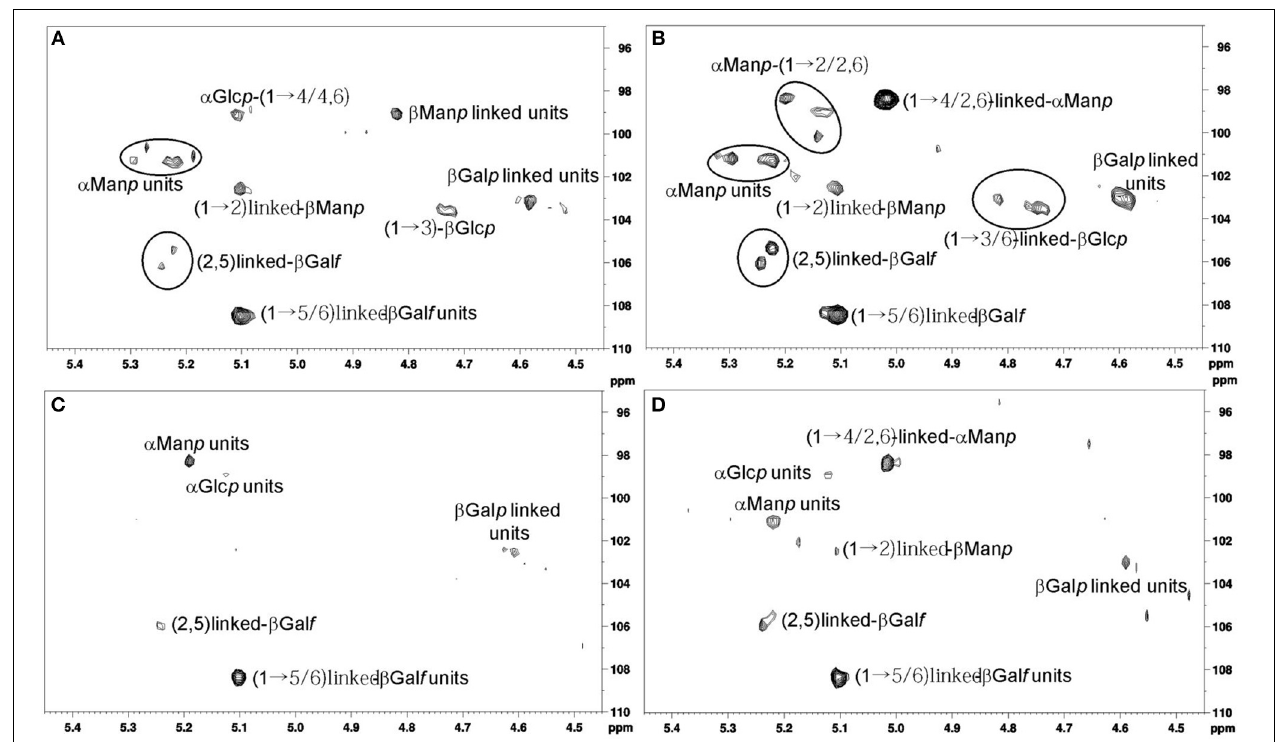
FIGURE 2 | (A) Anomeric region analysis of strain MMHC82 spectrum for MM. (B) Anomeric region analysis of strain MMHC82 spectrum for CD medium. (C) Anomeric region analysis of strain FE5p4 spectrum for MM. (D) Anomeric region analysis of strain FE5p4 spectrum for CD